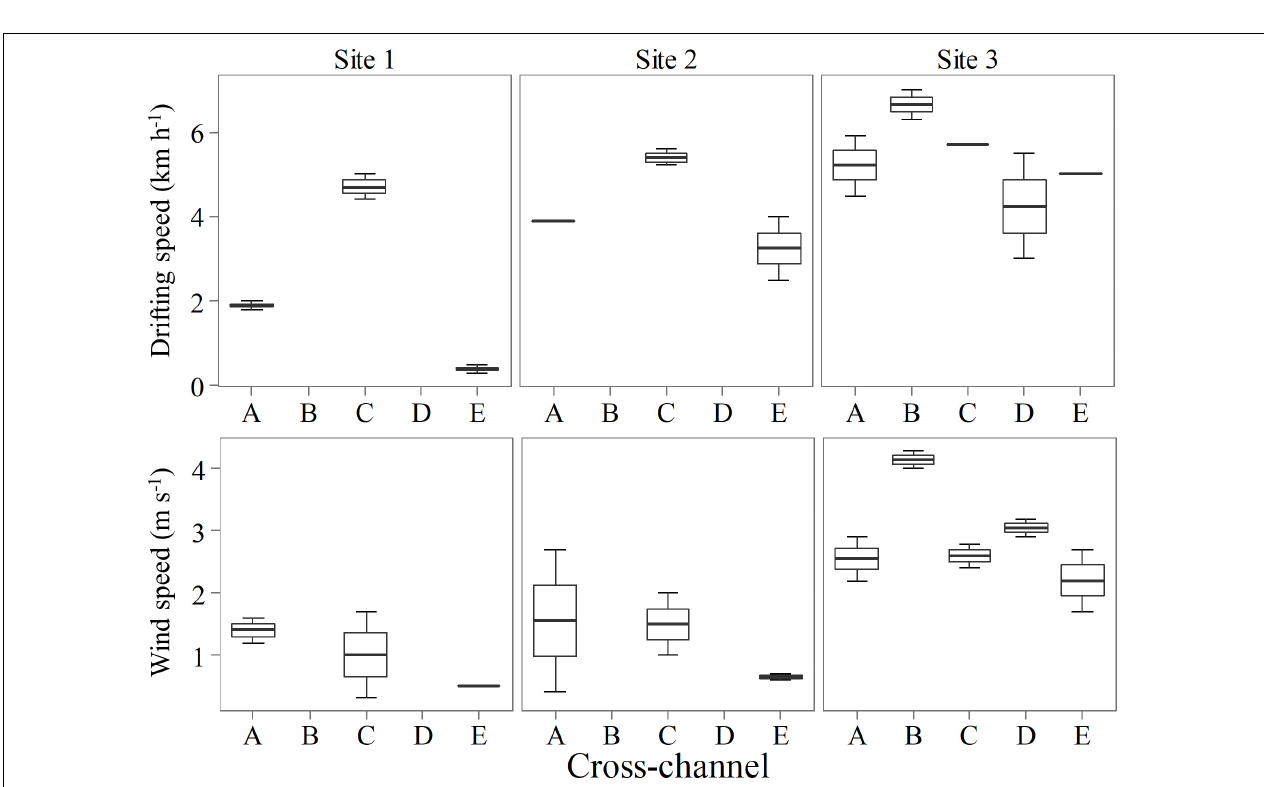
FIGURE 6 | Cross-channel variation in drifting speed of the boat and wind speed measured in two consecutive days for each site.